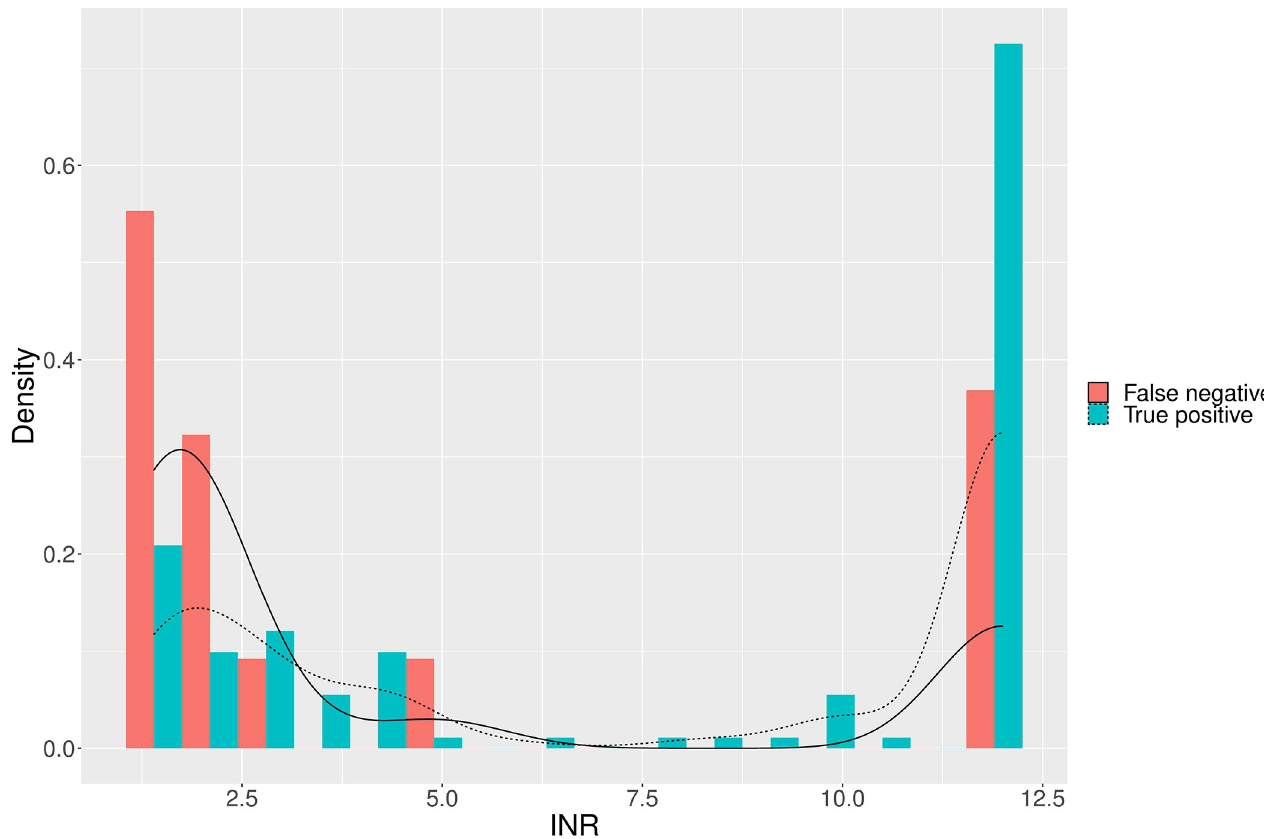
Fig 6. A density plot displaying the distribution of false negative and true positive 20WBCT results using a reference test of INR.